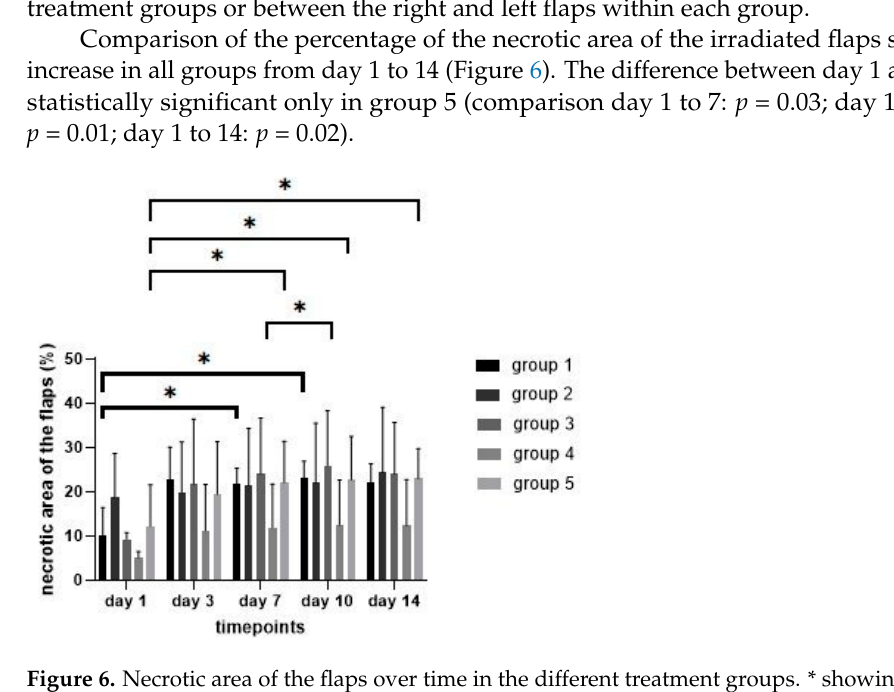
Figure 6. Necrotic area of the flaps over time in the different treatment groups. * showing statiscally significant differences ( p ≤ 0.05).